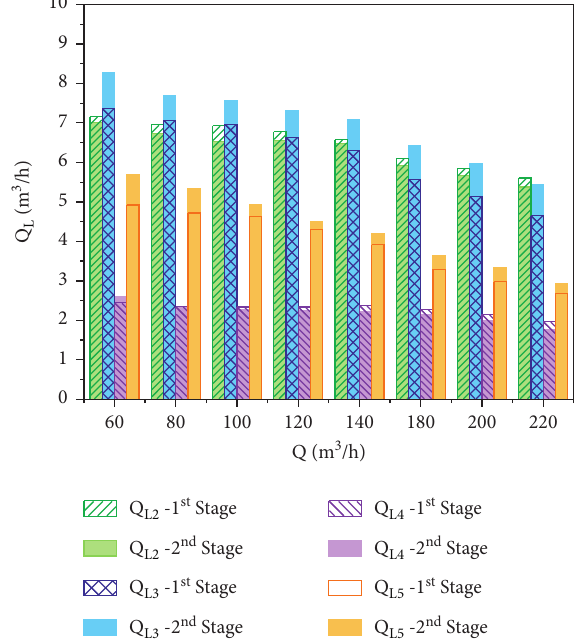
Figure 8: Leakage flow of the two stages under different flow